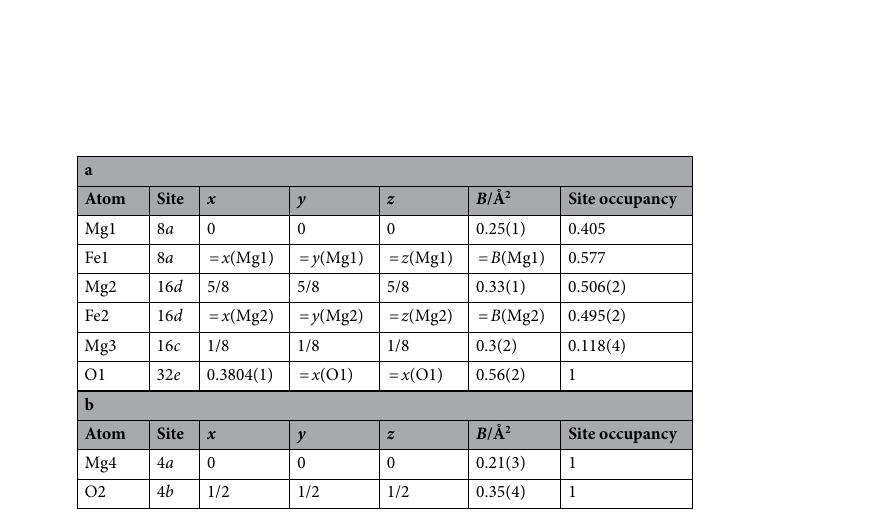
Table 2. Refined structural parameters of Mg-rich Mg–Fe–O under an assumption that the sample is composed from ( a ) the Mg-rich spinel oxide (S. G.: Fd -3 m ) and ( b ) MgO with a rocksalt structure (S. G.: Fm - 3 m ). The spinel phase can be expressed as Mg 1.651 Fe 1.566 O 4 , and the weight ratio is 69.6%. In this model, the 16 c site is occupied partially by the excess Mg. Lattice parameters: a = 8.39483(8) Å (spinel) and a = 4.2127(1) Å (rocksalt). R factors are R wp = 5.69%, R p = 4.44%, and R e =